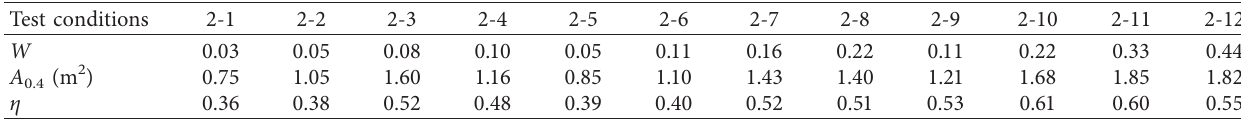
Figure 7: Amplitude reduction ratio contour map for test conditions (a) 2-5, (b) 2-7, and (c) 2-8. Table 7: List of vibration isolation